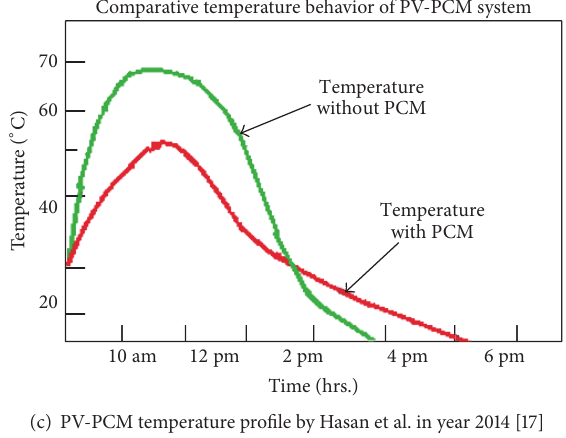
Figure 10: Comparative temperature profile of PV-PCM system obtained by different researchers. Table 1: Comparative performance analysis of the PV-PCM system obtained by different researchers [11, 16, 17, 24]. Researchers Used PCM Temperature without